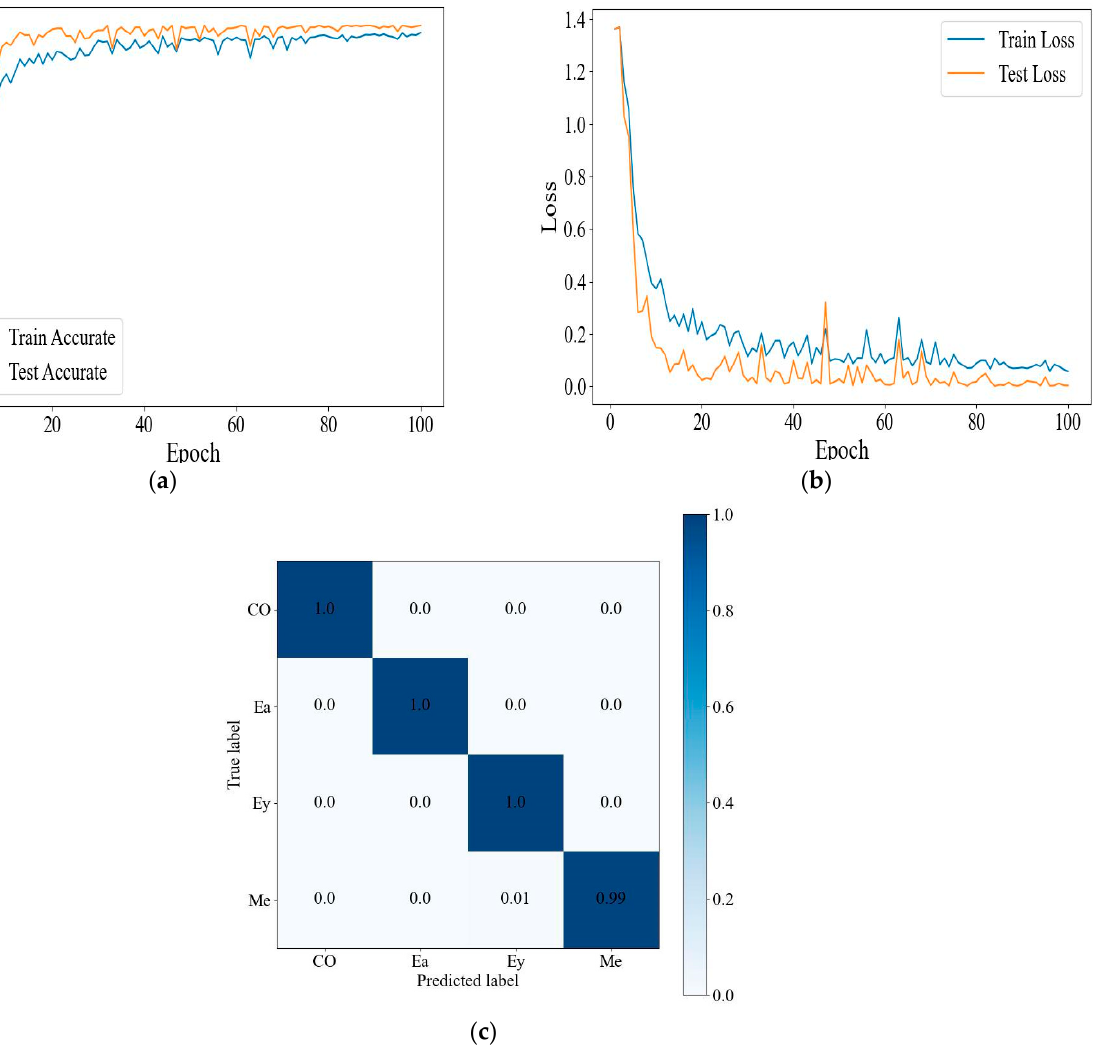
Figure 13. ( a ) The training and test accuracy curves of the comparison experiment. ( b ) The training and test loss curves of the comparison experiment. ( c ) Confusion matrix of the comparison experi- ment.